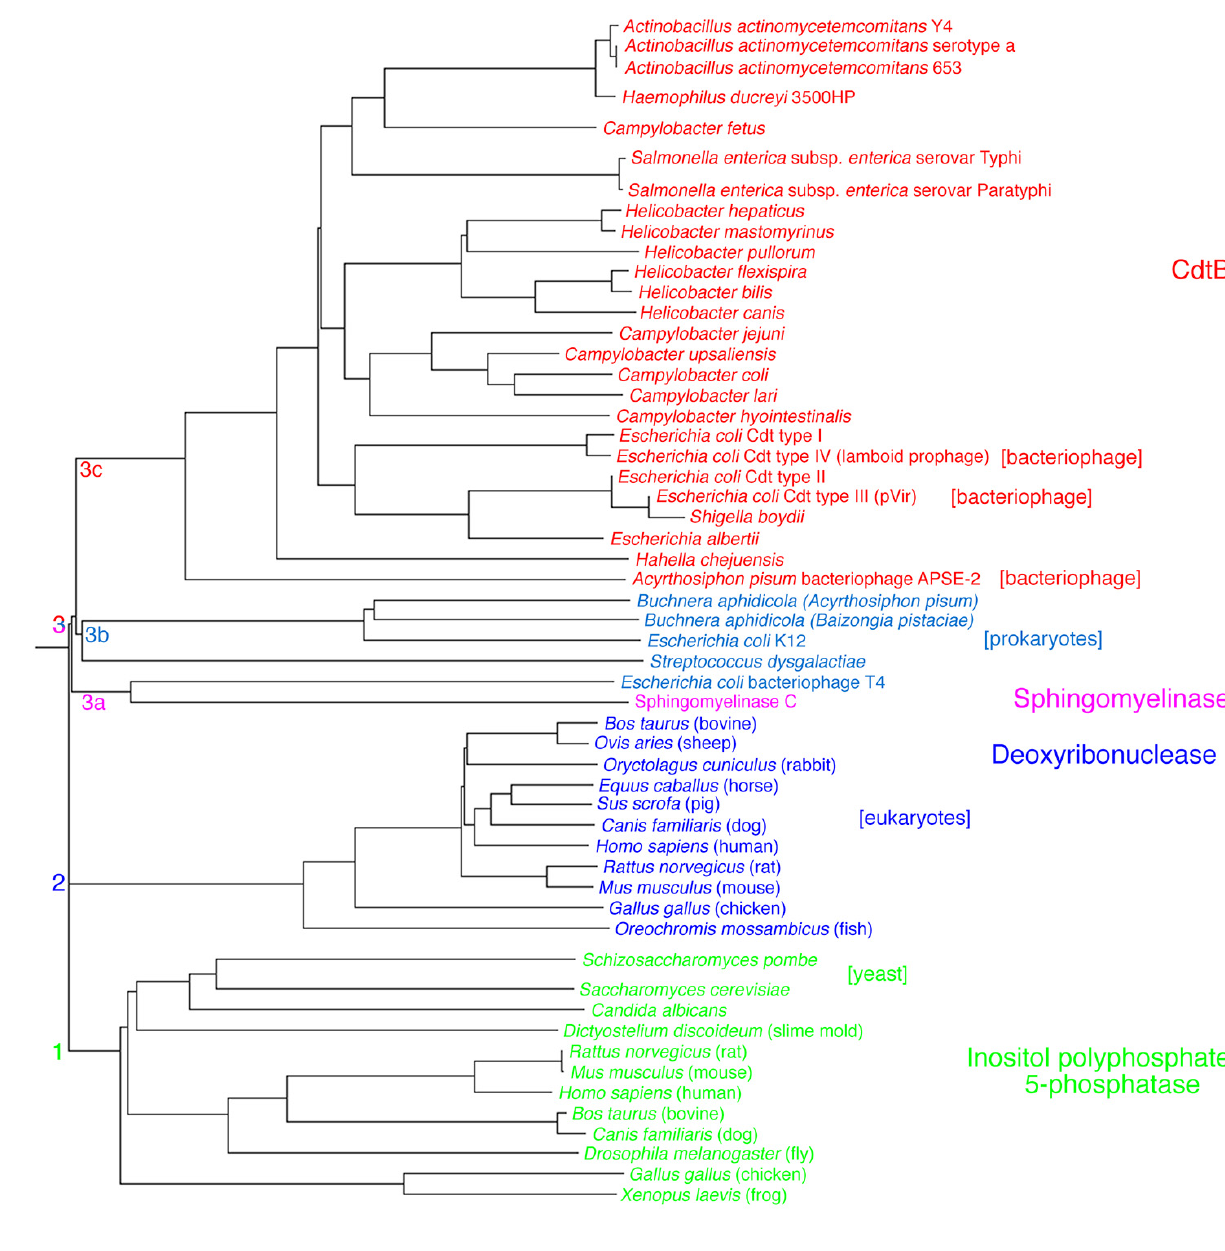
Figure 2. Rooted phylogenetic tree of the deduced amino acid sequences of a representative group of deoxyribonucleases (DNase I), inositol polyphosphate 5-phosphatases and sphingomyelinase. The tree was constructed with PHYLIP 3.6. The lengths of the lines show relative genetic